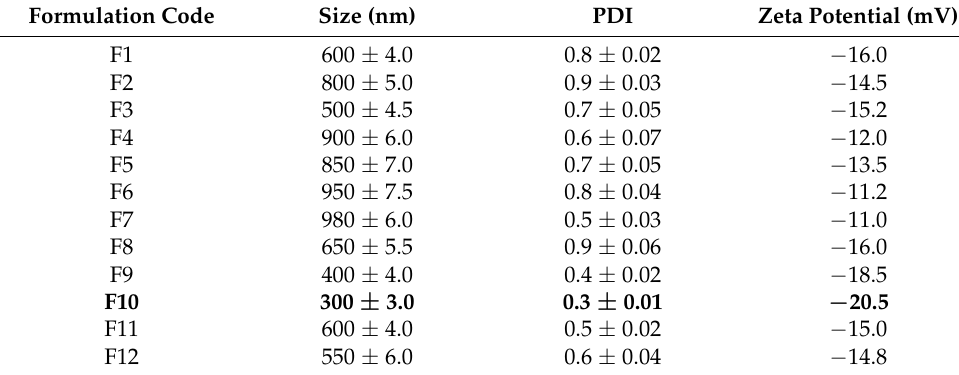
Table 2. Physicochemical evaluation of the prepared LX NCs. Formulation